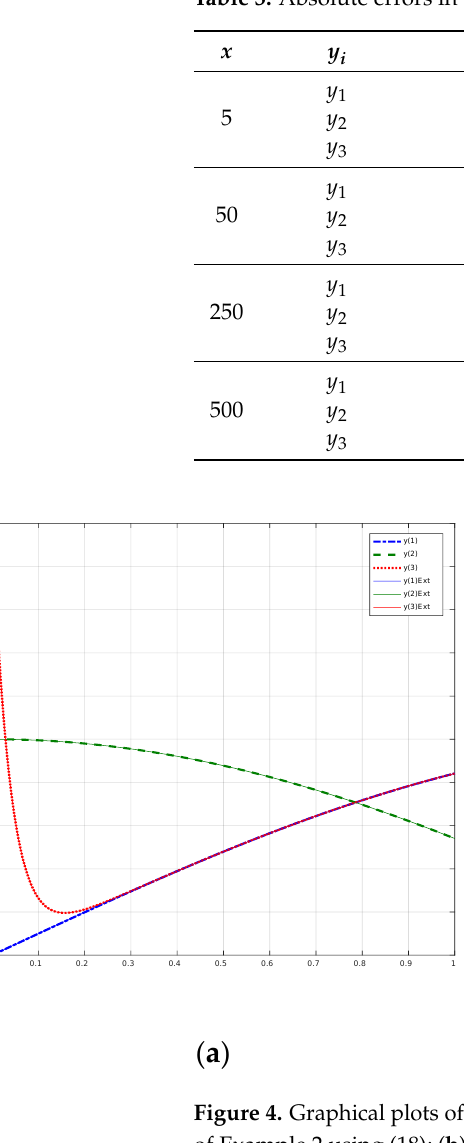
Table 3. Absolute errors in the numerical integration of example 2.